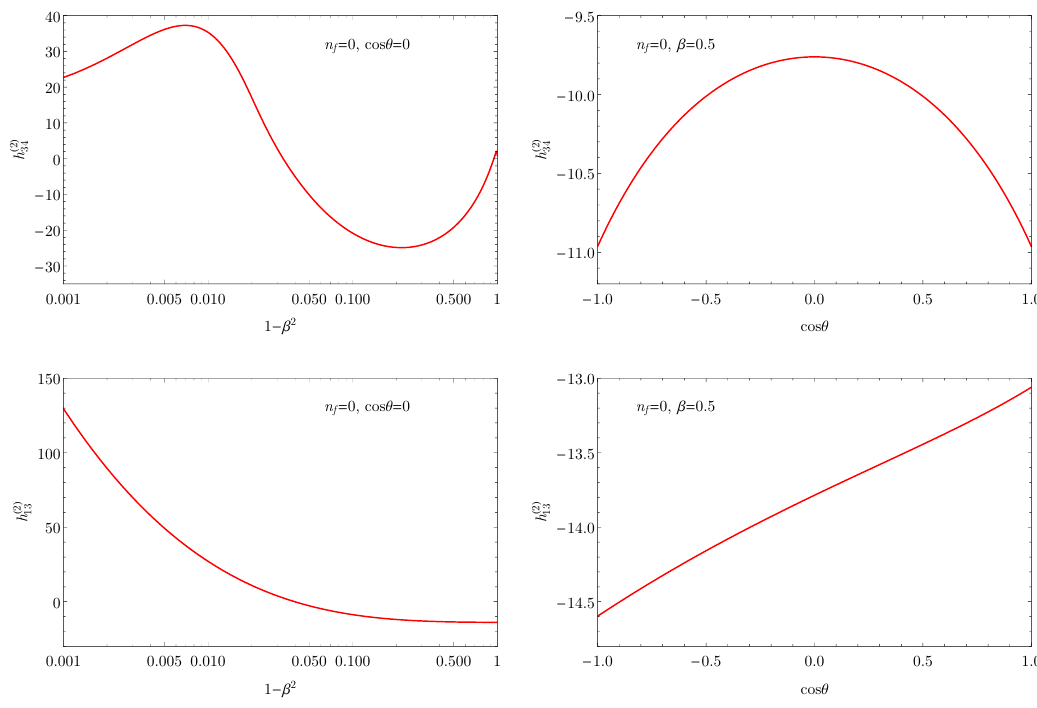
Figure 2 . Contributions to the second order coefficient of h proportional to T 3 · T 4 (upper panels) and T (lower panels). The results correspond to n 1 · T 3 for a fixed value of cos θ = 0 , while the cos θ dependence is shown in the right panels for β = 0 . 5